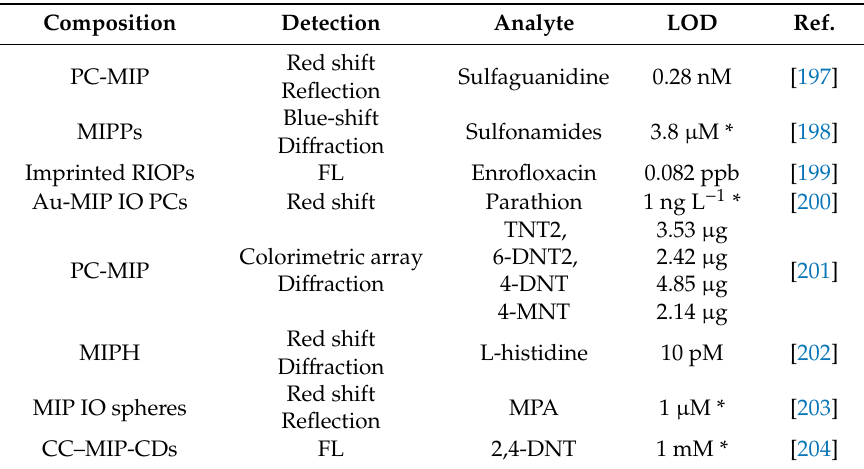
Table 11. Optical sensors based on photonic